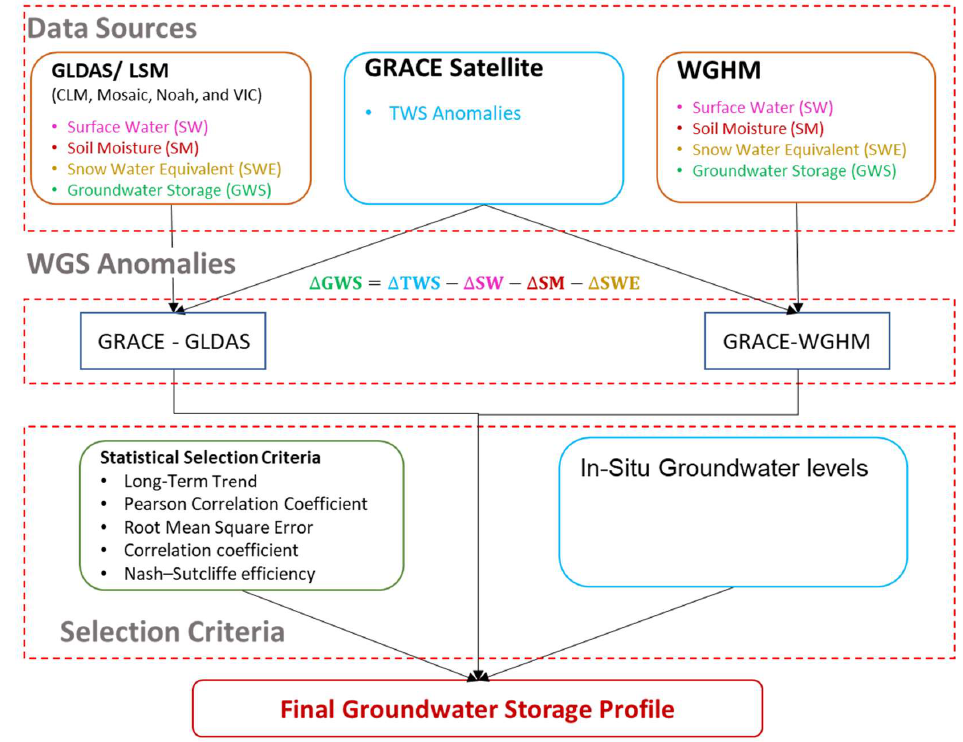
Figure 5. GRACE–GLDAS and GRACE–WGHM processing to get GWS from TWS.